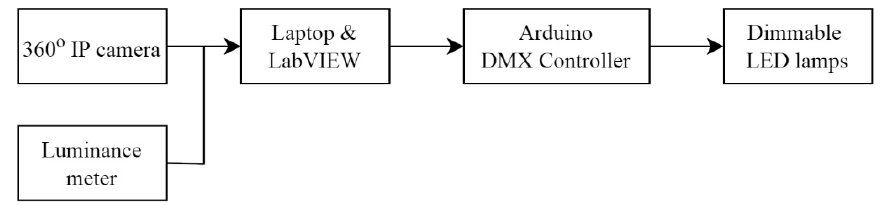
Figure 1. ( a ) The prototype is set on a 1.5 × 1.5 m 2 area; ( b ) The model for the closed room without daylight scheme; ( c ) The model for the room with a window on one side and daylight is presented; ( d ) The layout of the prototype; ( e ) The arrangement of lamps.